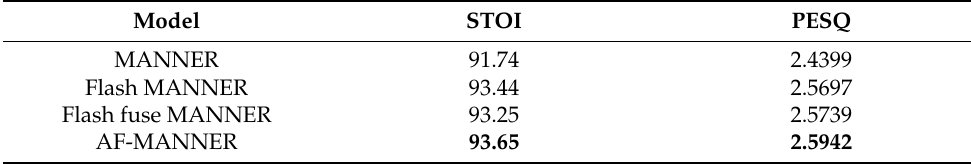
Table 2. Comparison of objective scores of enhanced speech